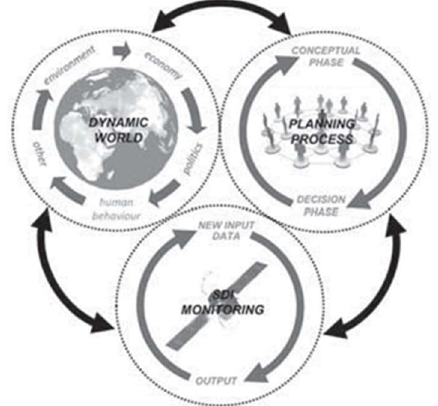
Figure 1. SDI as data provider in the never-ending planning cycle. Resources: M. Schrank, J. Neuschmis, D. Petti, and W. Wasserburger [16].